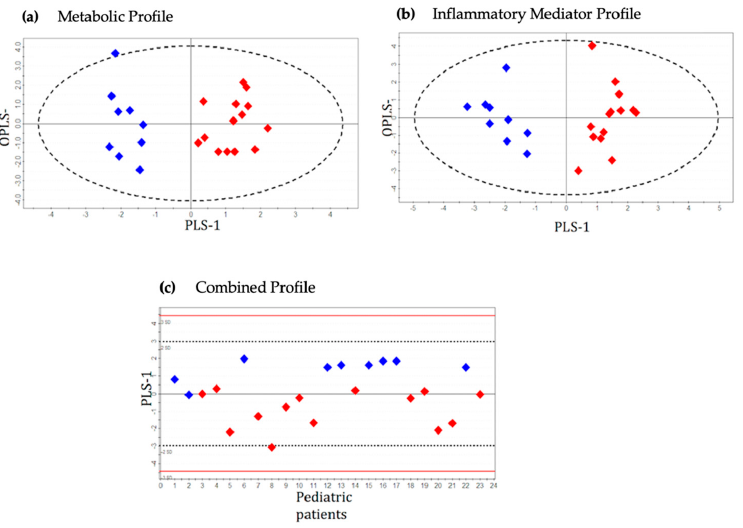
Figure 2. OPLS-DA score scatter plots distinguishing pediatric patients with severe appendicitis and moderate appendicitis using ( a ) metabolic profile (R 2 Y = 0.90, Q 2 = 0.70), ( b ) inflammatory me- diator profile (R 2 Y = 0.66, Q 2 = 0.56) and ( c ) combined metabolic and inflammatory mediator profile (R 2 Y = 0.78, Q 2 = 0.65). Red diamonds represent distribution of pediatric patients with severe appen- dicitis, and blue diamonds represent patients with moderate appendicitis. OPLS—Orthogonal Par- tial Least Squares; PLS—Partial Least Squares